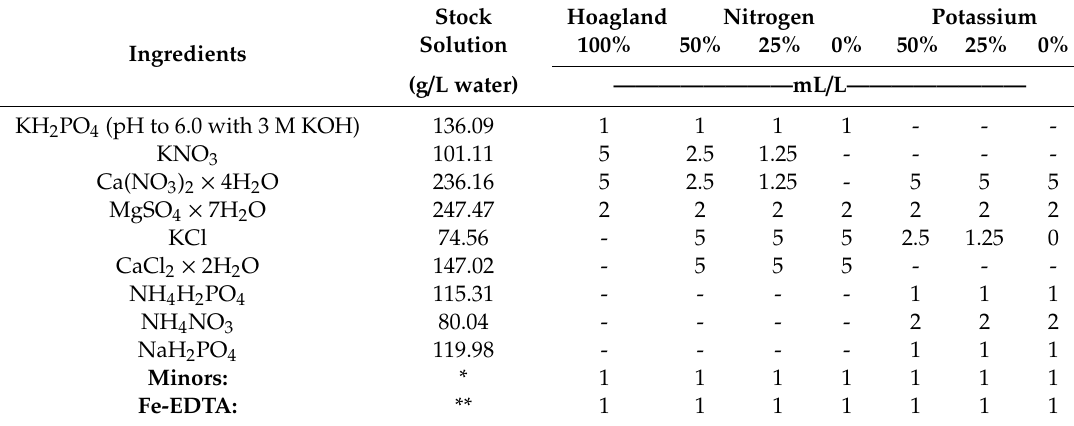
Table 1. Concentration of nutrients in di ff erent rates of Hoagland’s solution created for di ff erent treatments of N and K. Stock Ingredients ————————mL / L———————— KH 2 PO 4 (pH to 6.0 with 3 M